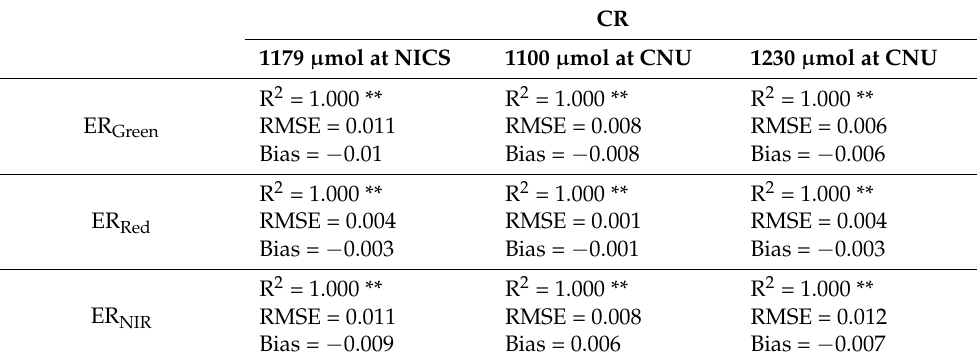
Table 4. Coefficient of determination (R 2 ) and root mean square error (RMSE) between the estimated reflectances at the green (ER Green ), red (ER Red ), and NIR (ER NIR ) and corrected reflectances (CR) for the field images obtained using the RAV RSS at different light intensities of 1179 µ mol at the National Institute of Crop Science (NICS) and 1100 µ mol and 1230 µ mol at Chonnam National University (CNU). CR 1100 µ mol at CNU